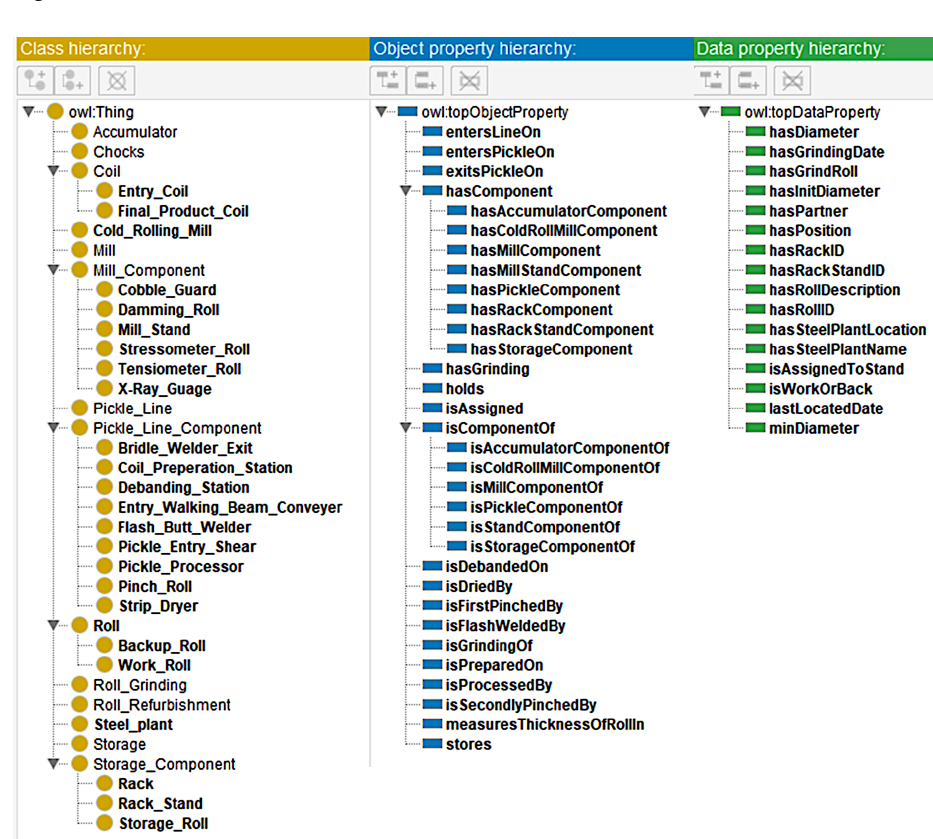
Figure 2. Classes, object properties, and data properties of